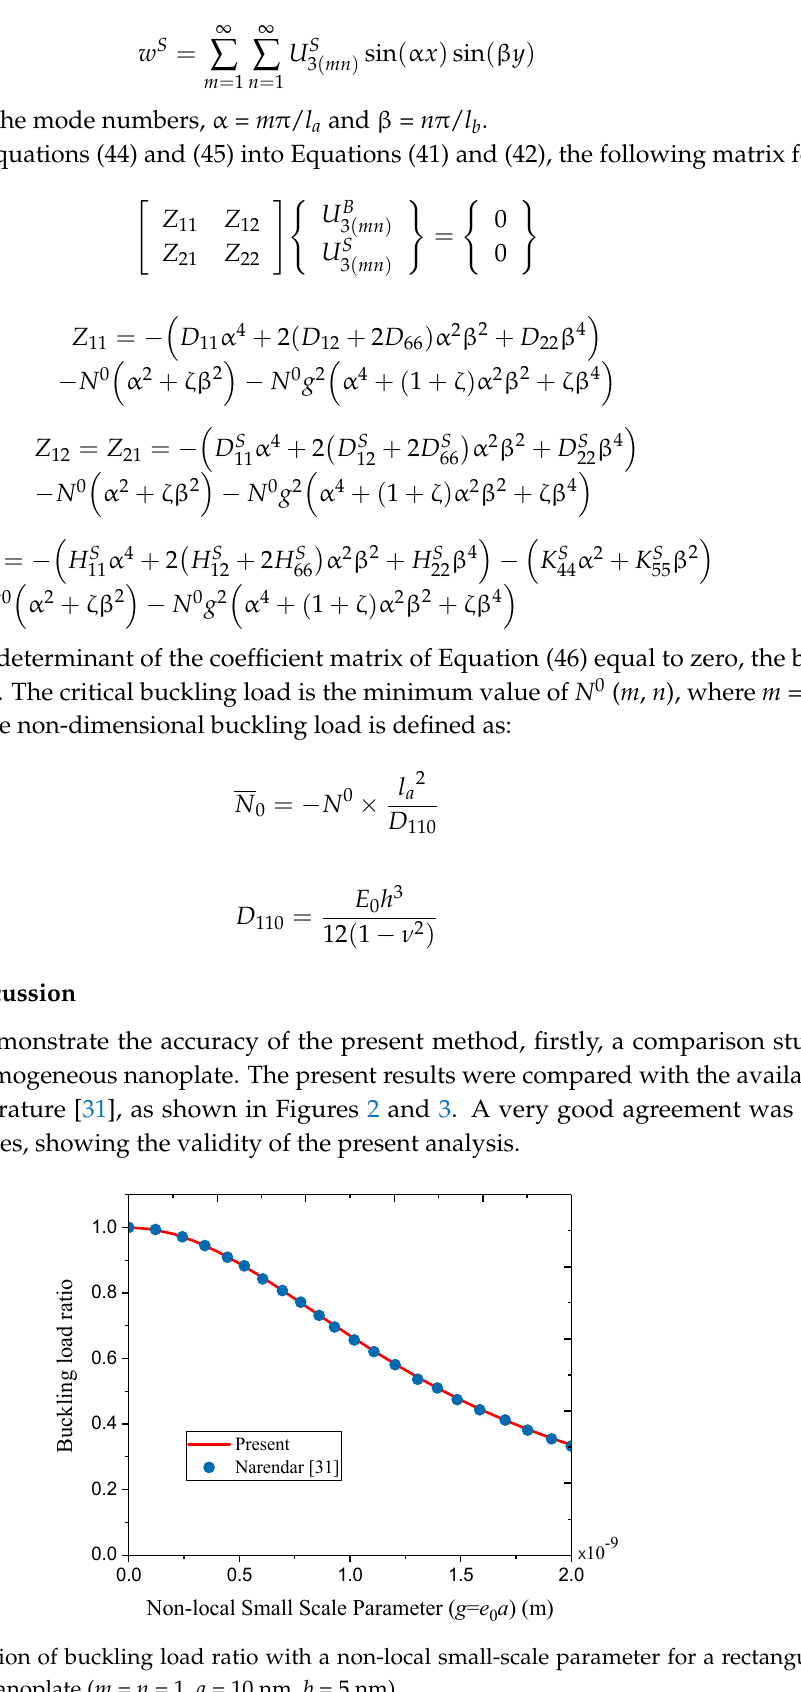
m =1, n =1 Figure 3. Variation of buckling load ratio with a non-local small-scale parameter for a square homogeneous nanoplate ( a = b = 5 nm). In the following, the FG nanoporous metal foam nanoplate shown in Figure 1 was considered. It had the following material properties: E 0 = 200 Gpa, G 0 = 76.92 Gpa and ν = 1/3. The variation of non-dimensional buckling load with a mode number n of FG nanoporous metal foam nanoplate is shown in Figure 4 for different small-scale parameters. It could be observed that the non-dimensional buckling load increased with an increasing mode number n . In addition, the non-dimensional buckling load decreased with the increase of the small-scale parameter. The classical theory ( g = 0) resulted in the highest buckling load. It was also seen that when the mode number n was small, there was no significant difference among non-dimensional buckling loads for different small-scale parameters. However, as mode number n increased, the nonlocal effect became more and more notable.